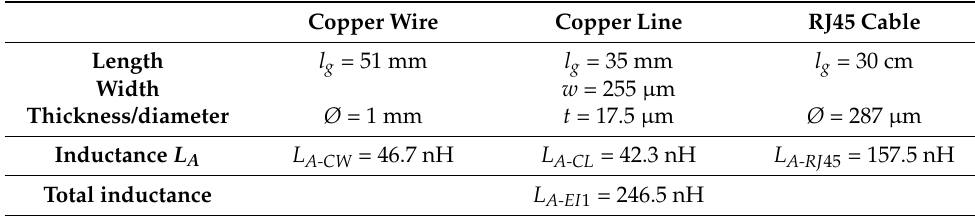
Table 6. Dimensions and estimated values of the different parasitic inductances inside the EI1 interconnections.